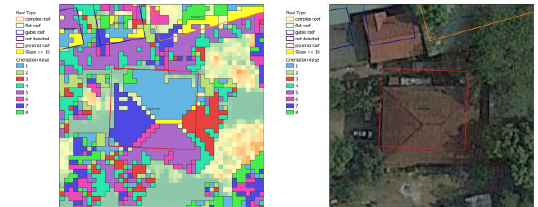
Figure 12. Pyramid roof building’s OSM building footprints overlaid on the aspect and slope map (left) and aerial photo Figure 16. Sample 3D reconstructed building models for (e) (right). rectangular hipped, and (f) l-shaped hipped, (g) rectangular flat, (h) irregular